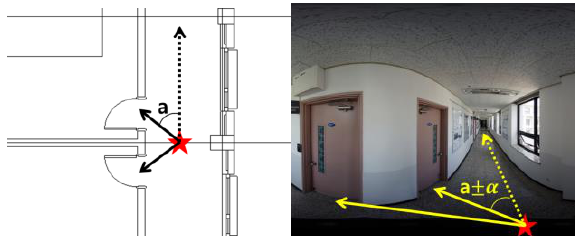
Figure 3. Finding a ROI on the image using shooting point and